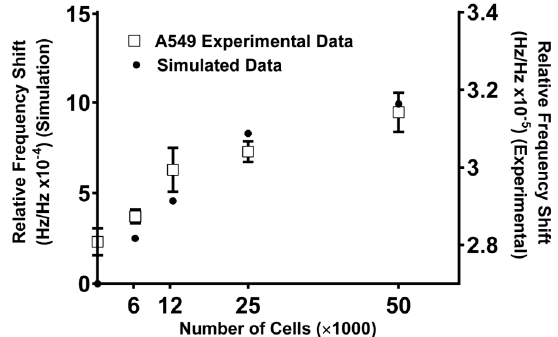
Figure 6. SAWs experiment data match the tendency of the simulation results on the ZnO coated sensor. Experimental data are plotted as mean ± standard error of the mean The data is a representative of a study that was performed in triplicates.